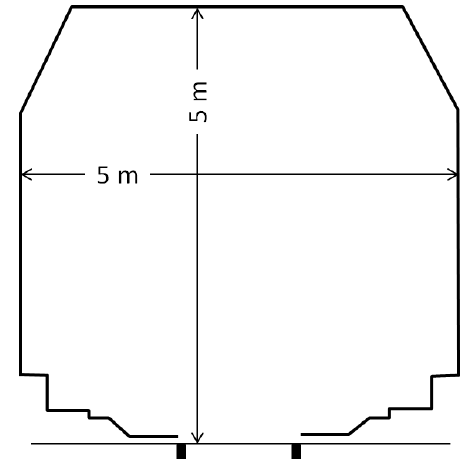
Figure 9: Definition of the space for the documentation of clearance narrow points (cf. Deutsche Bahn AG guidelines “Ril 458 458.0108”)